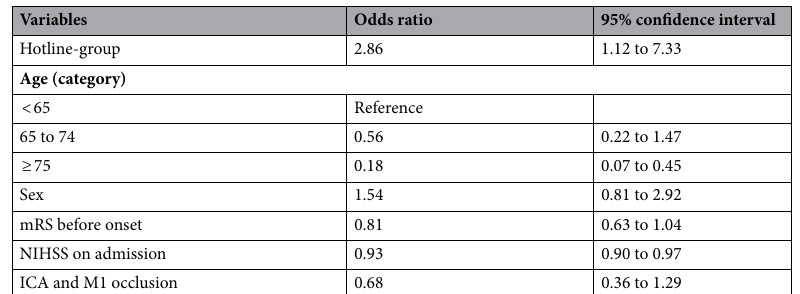
Table 3. Multivariate logistic regression analysis for good neurological outcome in patients with large vessel occlusion who received endovascular therapy. We calculated adjusted odds ratios for good neurological outcomes using a multivariate logistic model, in which we selected variables as follows: age (< 64, 65 to 74, ≥ 75 years), sex, mRS before onset, NIHSS in admission, ICA and M1 occlusion. mRS modified Rankin